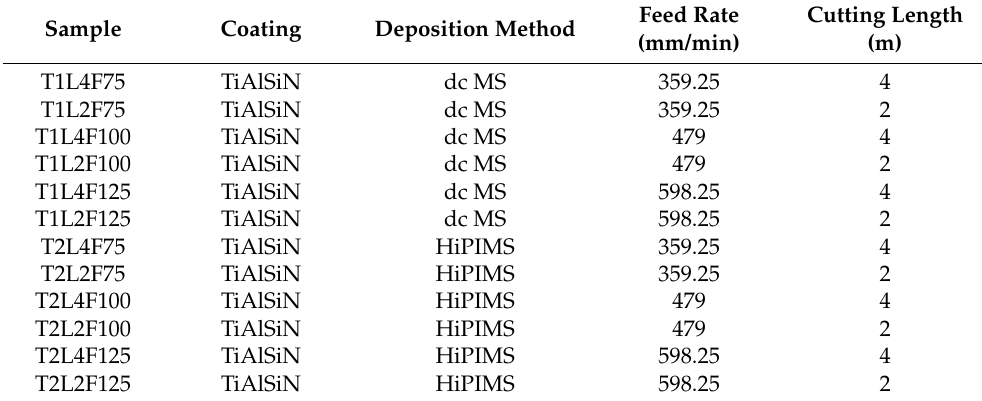
Table 3. Chosen parameters for the machining